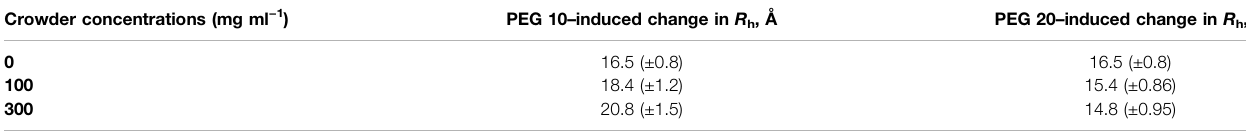
TABLE 2 | R h and V h values of cyt c in the presence of different concentrations — lowest and highest concentrations of PEG 10 and PEG 20 a . Crowder concentrations (mg ml − 1 )